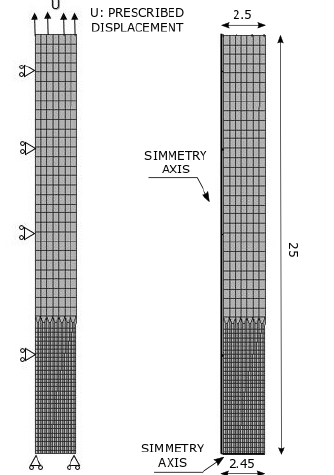
Figure 7. Tension test: finite element mesh and boundary conditions (dimensions in